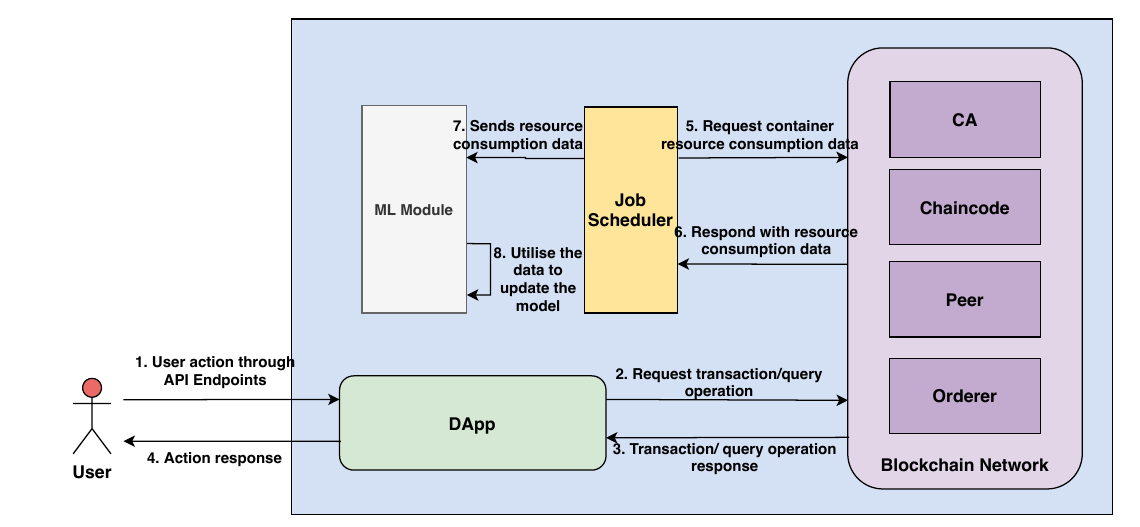
Figure 3. System